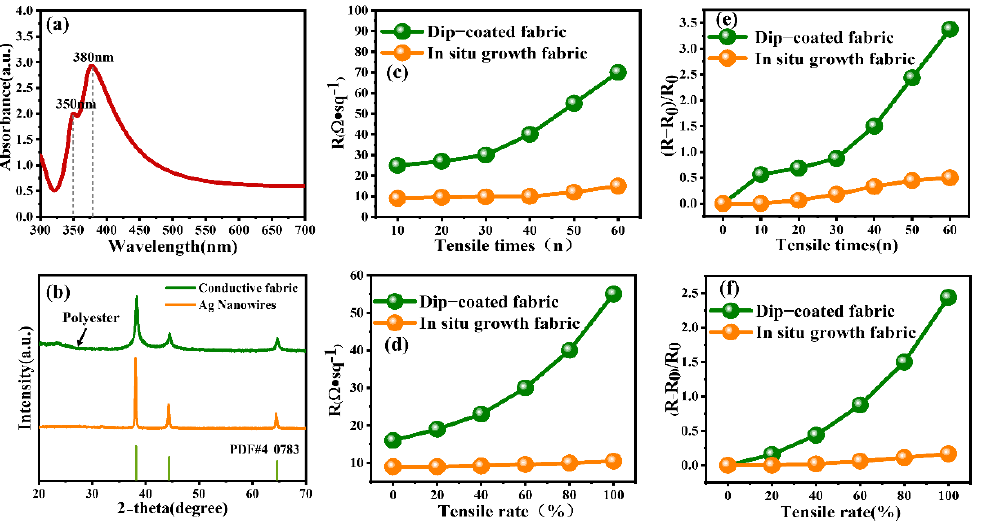
Figure 7. ( a ) UV–Vis image of Ag nanowires. ( b ) X-ray diffraction (XRD) patterns of in situ growth conductive fabric and Ag nanowires. ( c ) The square resistance of two kinds of conductive fabric changes after stretching up to 60 times. ( d ) The square resistance of two kinds of conductive fabric changes from tensile rate to 100%. ( e ) Normalized relationship between square-resistance change and tensile times. ( f ) Normalized relationship between square-resistance change and tensile rate.